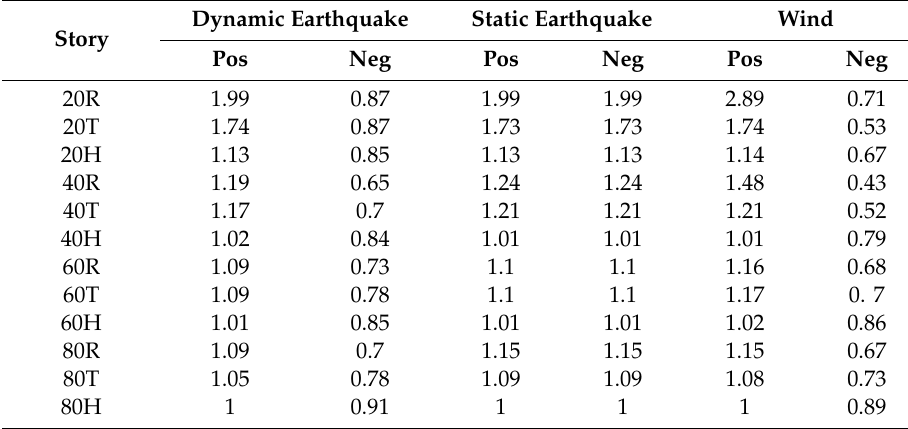
Table 4. The average of positive and negative shear lag factor in all models analyzed with three di ff erent load